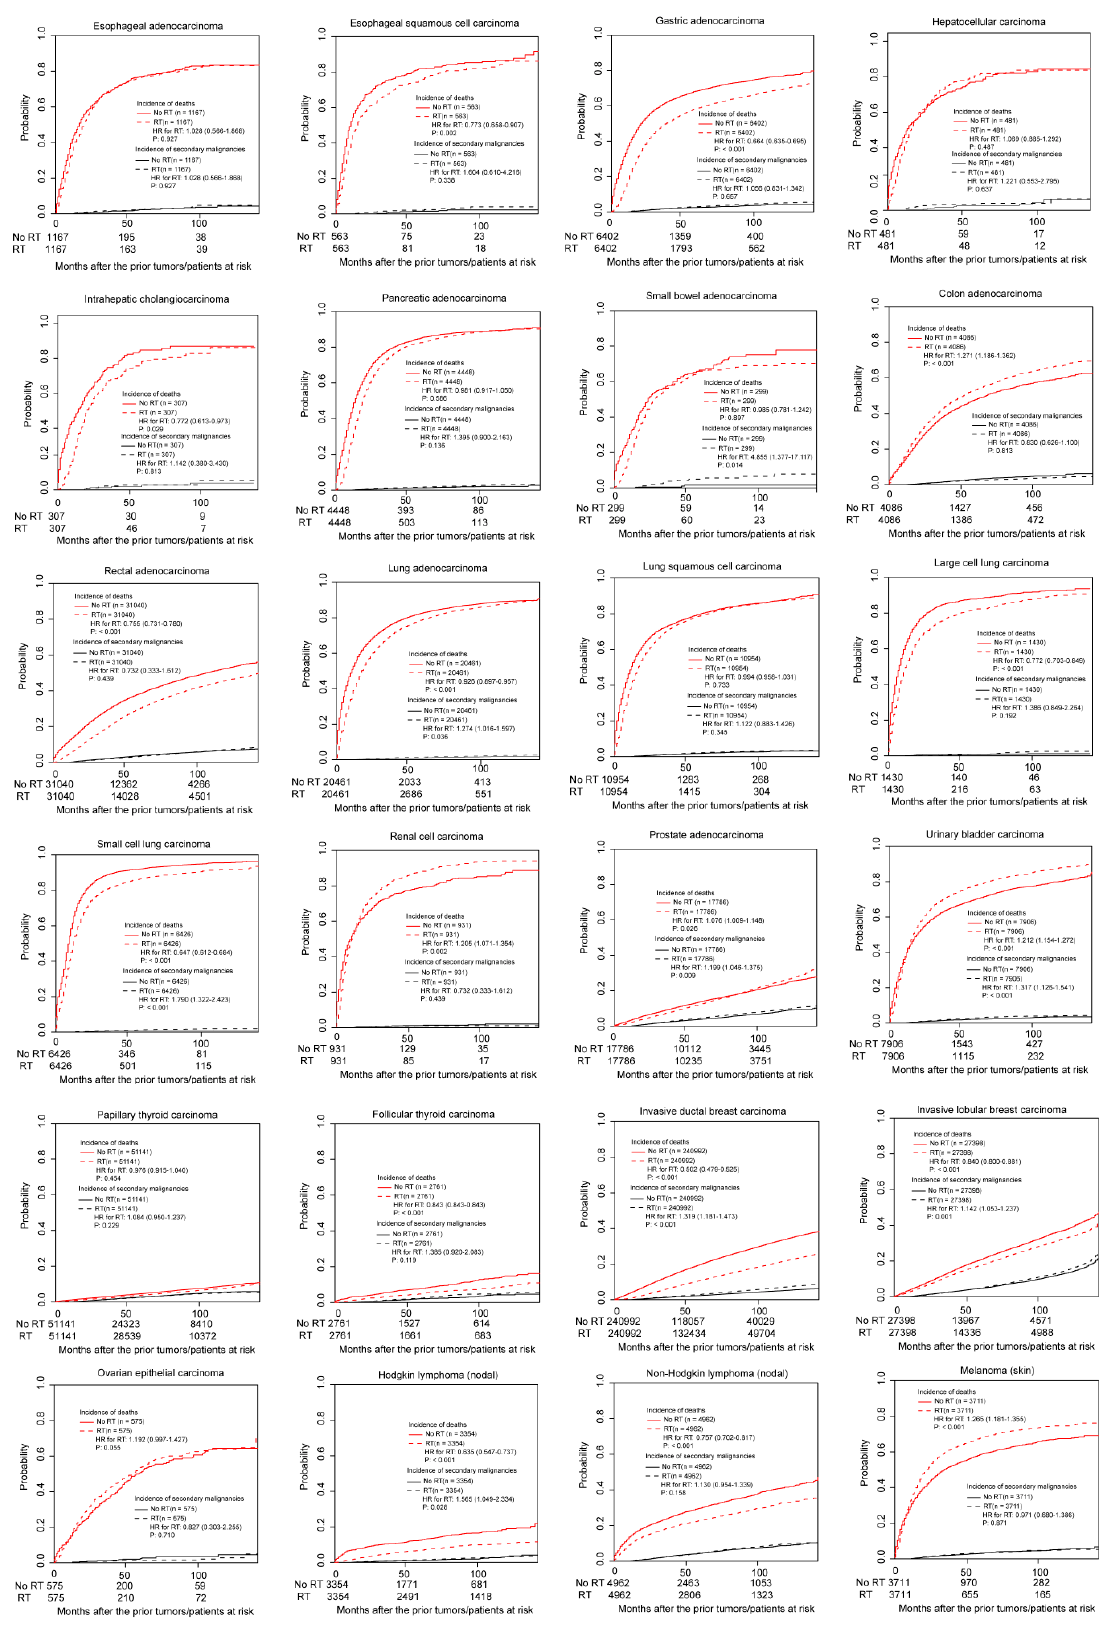
Figure 3. The cumulative incidences of death and secondary primary malignancy in the PSM-adjusted populations.